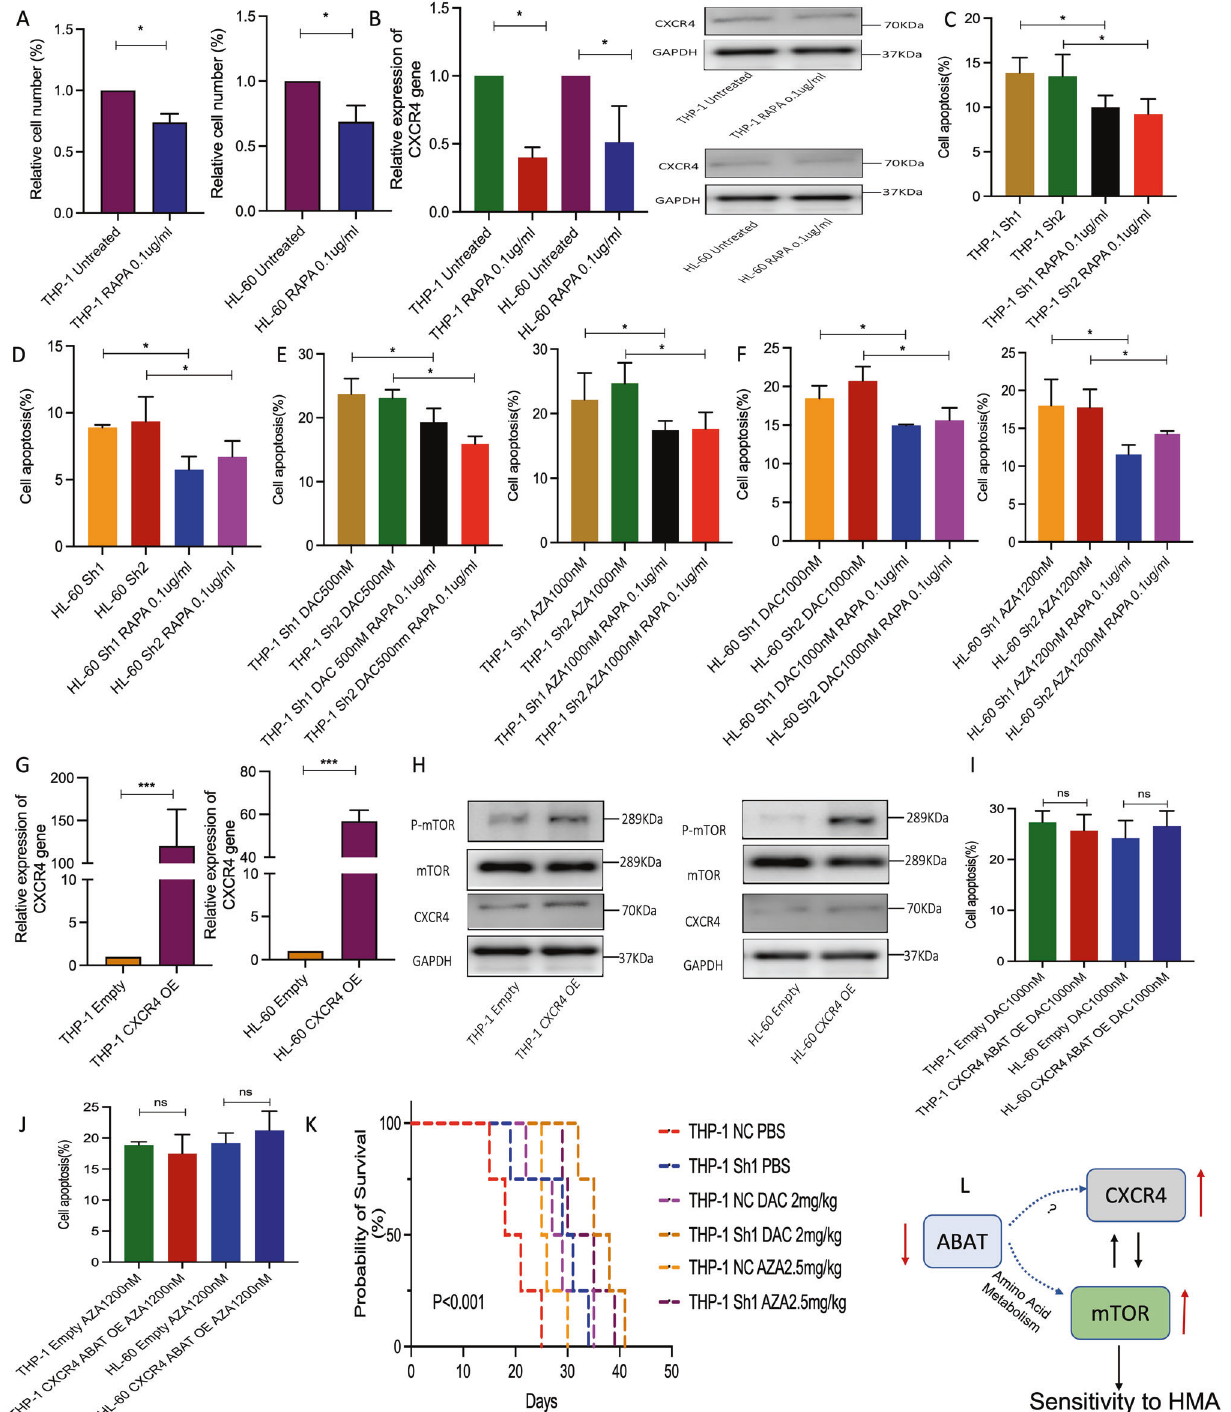
Fig. 5 CXCR4/mTOR regulation demonstrated in vitro and prognosis analysis of ABAT gene expression in vivo. A Cell number in THP-1 and HL-60 cells treated with RAPA. B Relative expression of CXCR4 gene in cells with RAPA treatment. Cell apoptosis in ABAT silenced THP-1 ( C ) and HL-60 ( D ) cells treated with RAPA. Percentage of apoptosis in ABAT silenced THP-1 ( E ) and HL-60 ( F ) cells after RAPA and HMAs treatment. G CXCR4 overexpression in THP-1 and HL-60 cells. H Protein expression of p-mTOR, mTOR, and CXCR4 in the above two cell lines with CXCR4 overexpression. Percentage of apoptosis in cells with ABAT and CXCR4 overexpression and DAC ( I ) and AZA ( J ) treatment. K The survival of NOD/SCID mice injected with ABAT silenced THP-1 cells and HMAs treatment (log-rank test). L Schematic of ABAT/CXCR4/mTOR regulation and sensitivity to HMAs. Data were represented as mean ± SEM from three biological samples. * P < 0.05, ** P < 0.01, *** P < 0.001. Student ’ s t - test (two groups) and one-way ANOVA analysis followed by Dunnett ’ s test (multiple groups). ns. not signi fi cant.